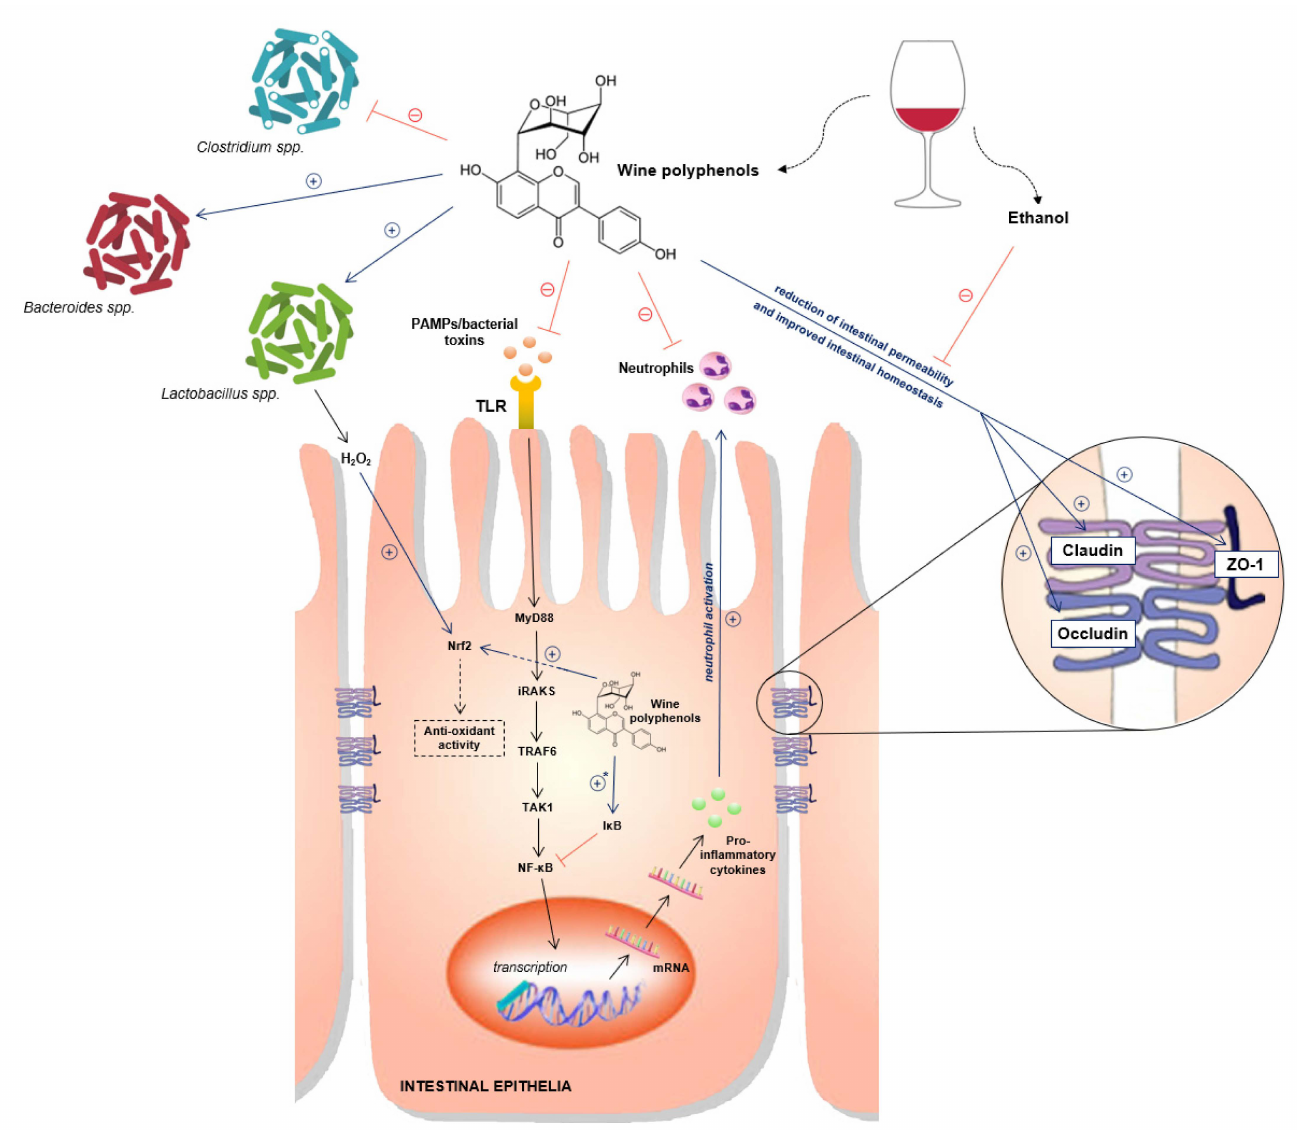
Figure 1. Multiple molecular targets of wine polyphenols contributing to its anti-inflammatory and anti-oxidant effects, changes in intestinal permeability and gut microbiota. Abbreviations: PAMPs: Pathogen-associated molecular patterns; ZO-1: Zonula occludens-1; TLR: Toll-like receptor; Nrf2: nuclear factor erythroid-derived 2; MyD88: Myeloid differentiation primary response 88; iRAKS: Interleukin-1 receptor associated kinase; TRAF6: Tumor necrosis factor receptor (TNFR)- associated factor 6; TAK1: transforming growth factor- β -activated kinase 1; NF- κ B: nuclear factor kappa-light-chain- enhancer of activated B cells; I κ B: inhibitor of nuclear factor kappa